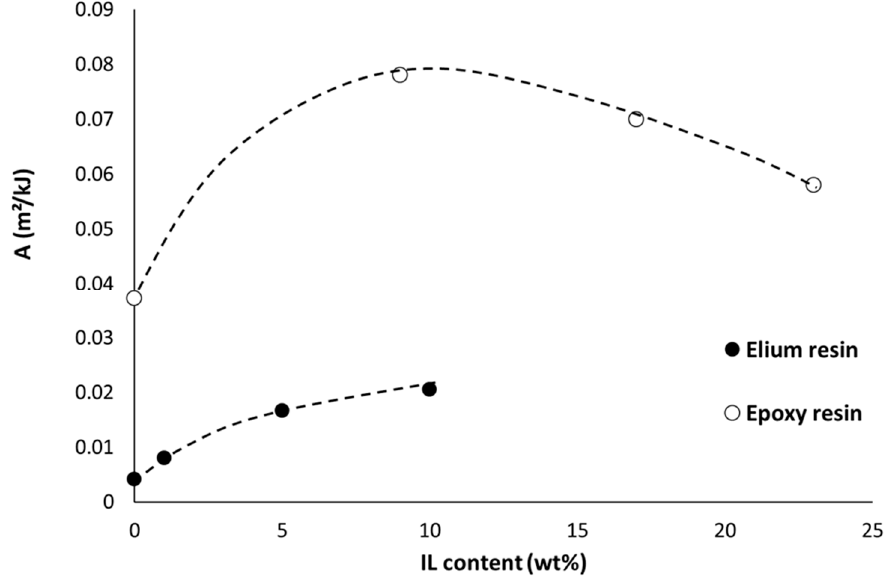
Figure 4. A value versus IL content in Elium and epoxy resins filled with IL169.